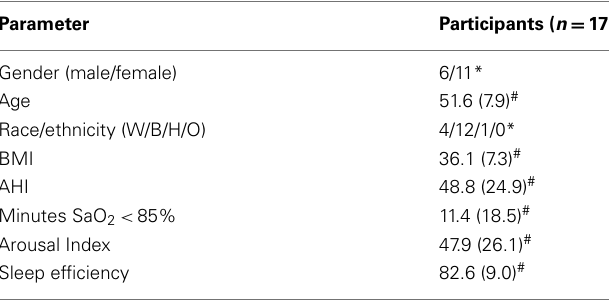
Table 1 | Baseline demographic characteristics.